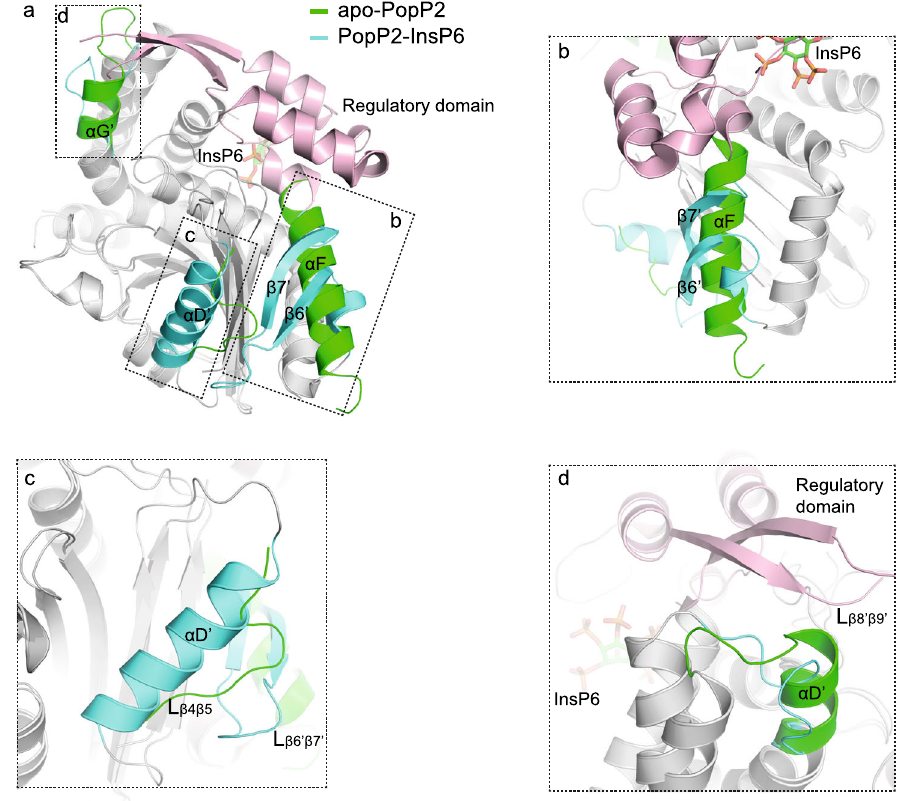
Fig. 2 Structural comparison of the apo- and InsP6-bound PopP2. a Overlap of the structures of the apo- and InsP6-bound PopP2. The well-overlapped catalytic core regions of both apo- and InsP6-bound PopP2 are colored in gray. The regulatory domain is colored in pink. Structures with obvious differences between the apo- and InsP6-bound PopP2 structures are colored in green for the apo-PopP2 and in cyan for the InsP6-bound PopP2, respectively. The major differences are highlighted in expanded view in b – d .